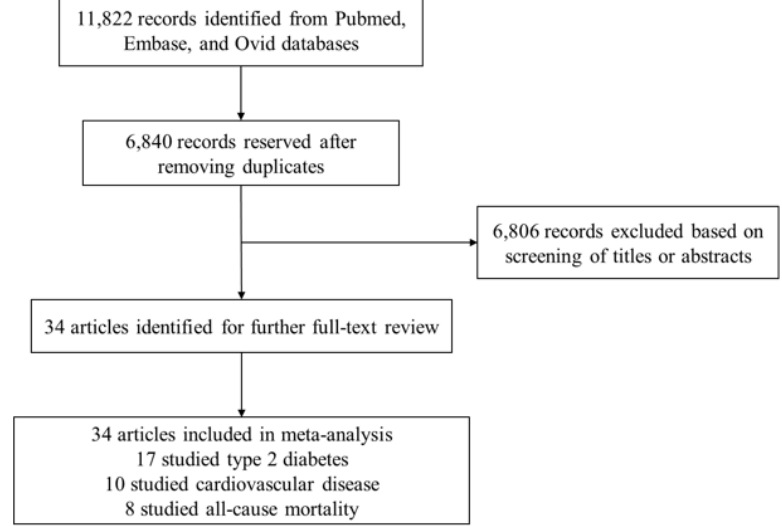
Figure 1. Selection of studies included in the meta-analysis.